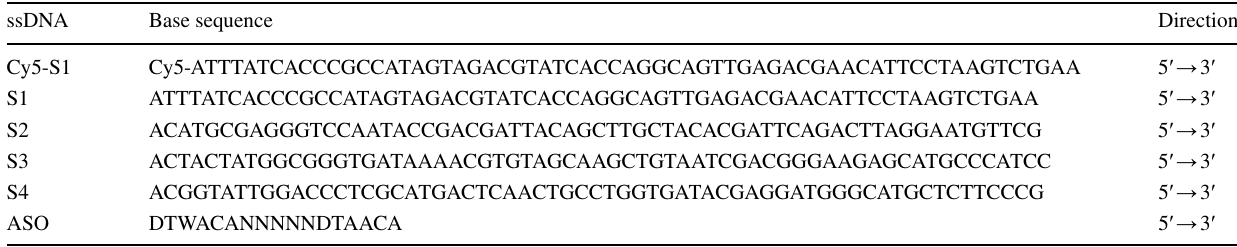
Table 1 Base sequence of each ssDNA